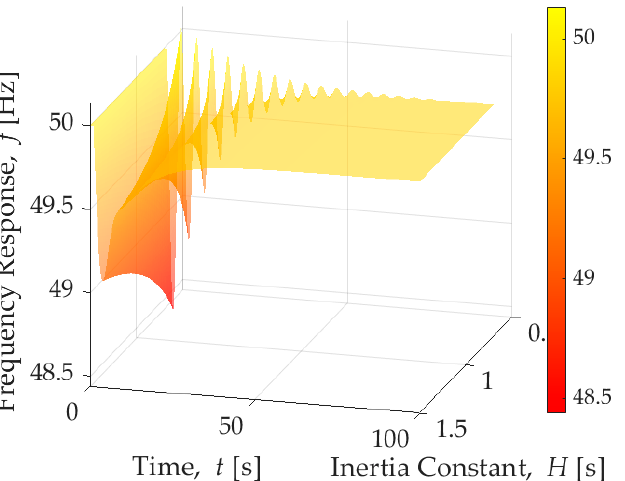
Figure 4. Frequency response ( f in Hertz) in a single area power system (shown in Figure 3, consid- ering changes in the inertia H ∈ [0.5, 1.5] s.